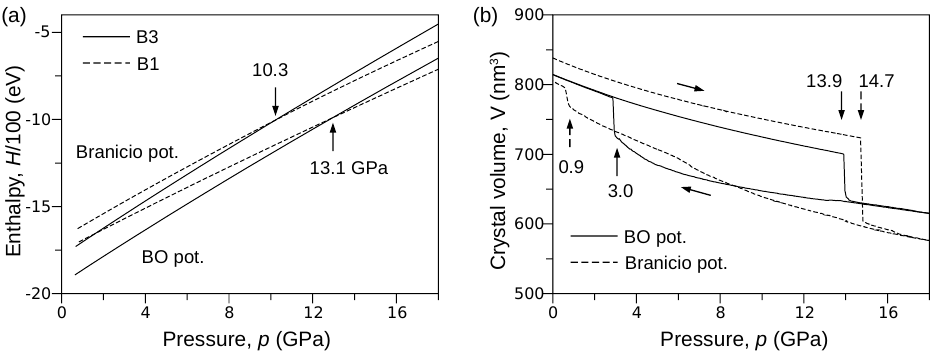
Figure 1. Results of MD simulations performed with the BO and Branicio potentials. ( a ) The relationship between the enthalpy H and the pressure p calculated for the B3 and B1 phases of InP crystal (4 × 4 × 4 unit cells). ( b ) Compression of the InP crystal (16 × 16 × 16 unit cells). The hysteresis of the B3 ↔ B1 transformation represented by the V ( p ) relationship (BO potential) reveals the reversibility of the phase